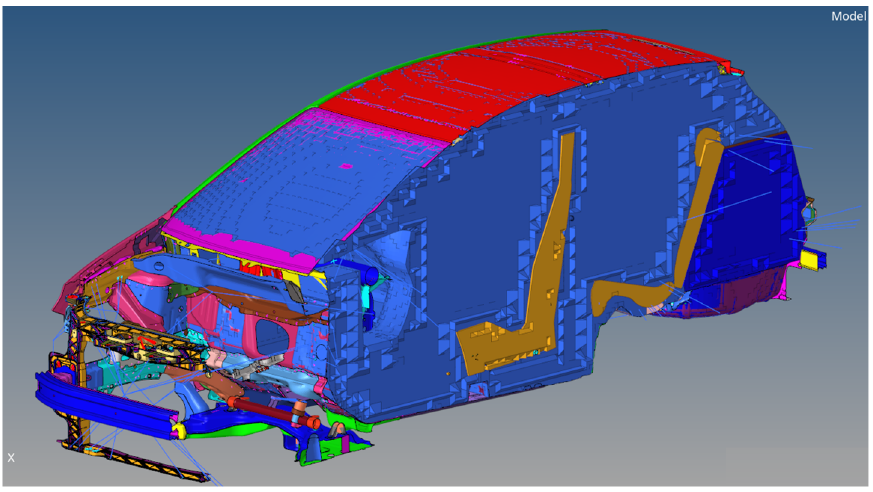
Figure 29. TB model with highlight of acoustic cavities: seats (brown), cockpit (cyan), boot (blue).